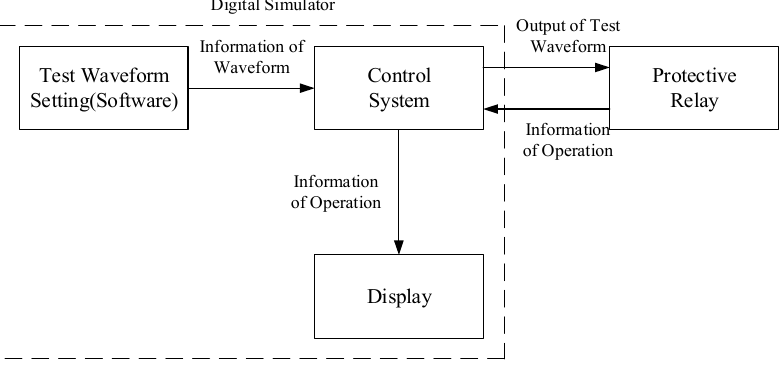
Figure 2. Data flow of the PREDIS-R.